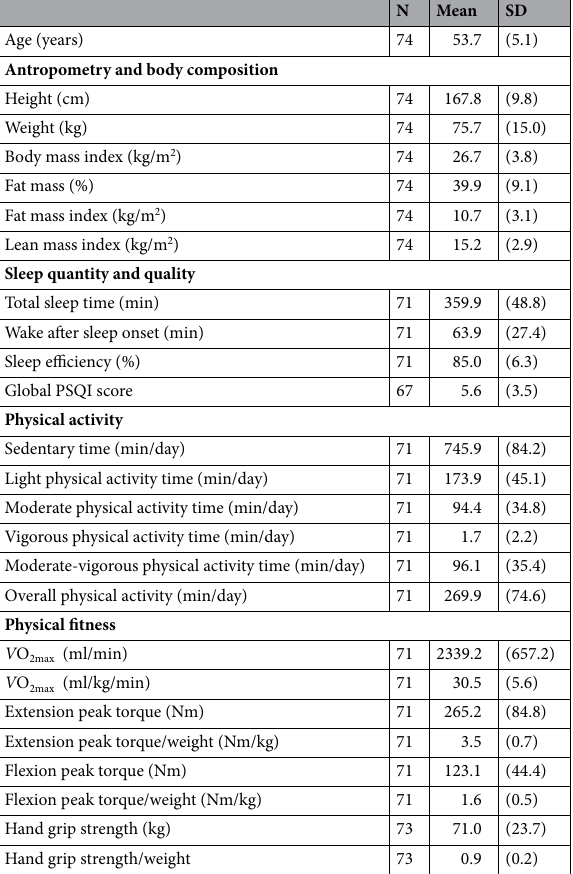
P = 0.002, Fig. 5E, respectively). Extension peak torque, flexion peak torque, and hand grip strength were nega- tively associated with global PSQI score when expressed relative to body weight ( β = − 0.313, R 2 = 0.098, P = 0.011, Fig. 5B; β = − 0.315, R 2 = 0.099, P = 0.011, Fig. 5D; β = − 0.366, R 2 = 0.134, P = 0.002, Fig. 5F, respectively).